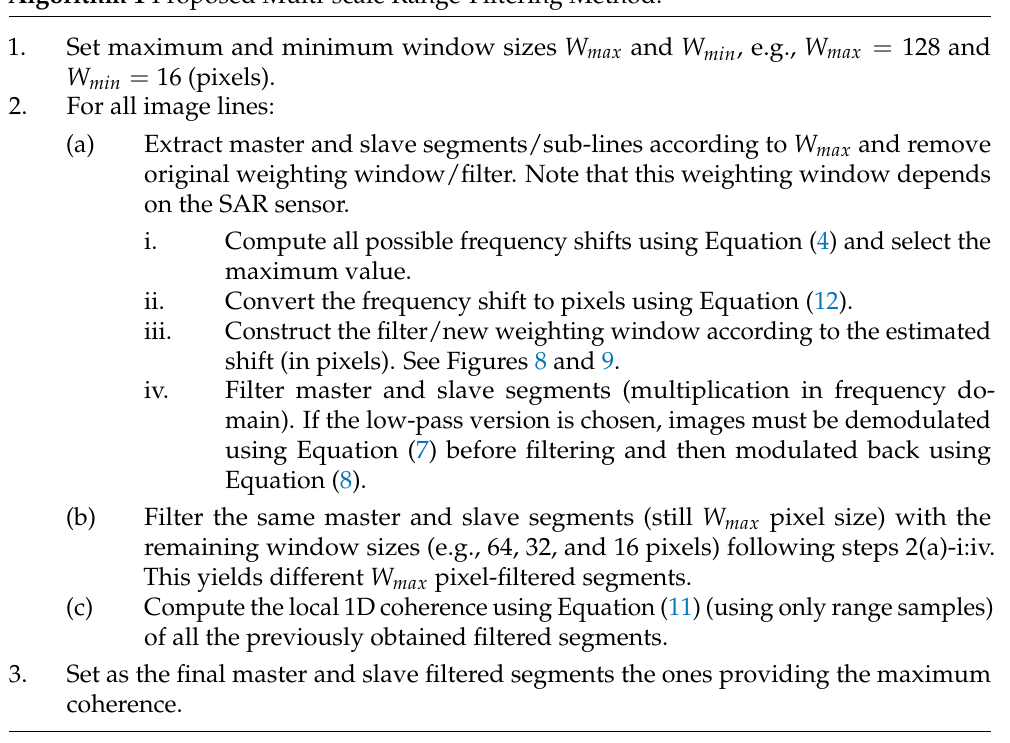
Algorithm 1 Proposed Multi-scale Range-Filtering Method.